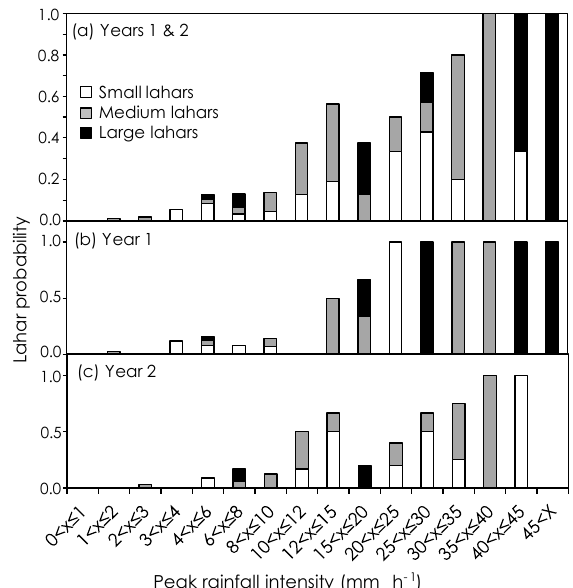
Figure 5. Lahar probability, classified by magnitude, as categorised 1h peak rainfall intensity (1hPRI) increases. (a) April 2010– April 2012; (b) April 2010–April 2011; (c) April 2011–April 2012.